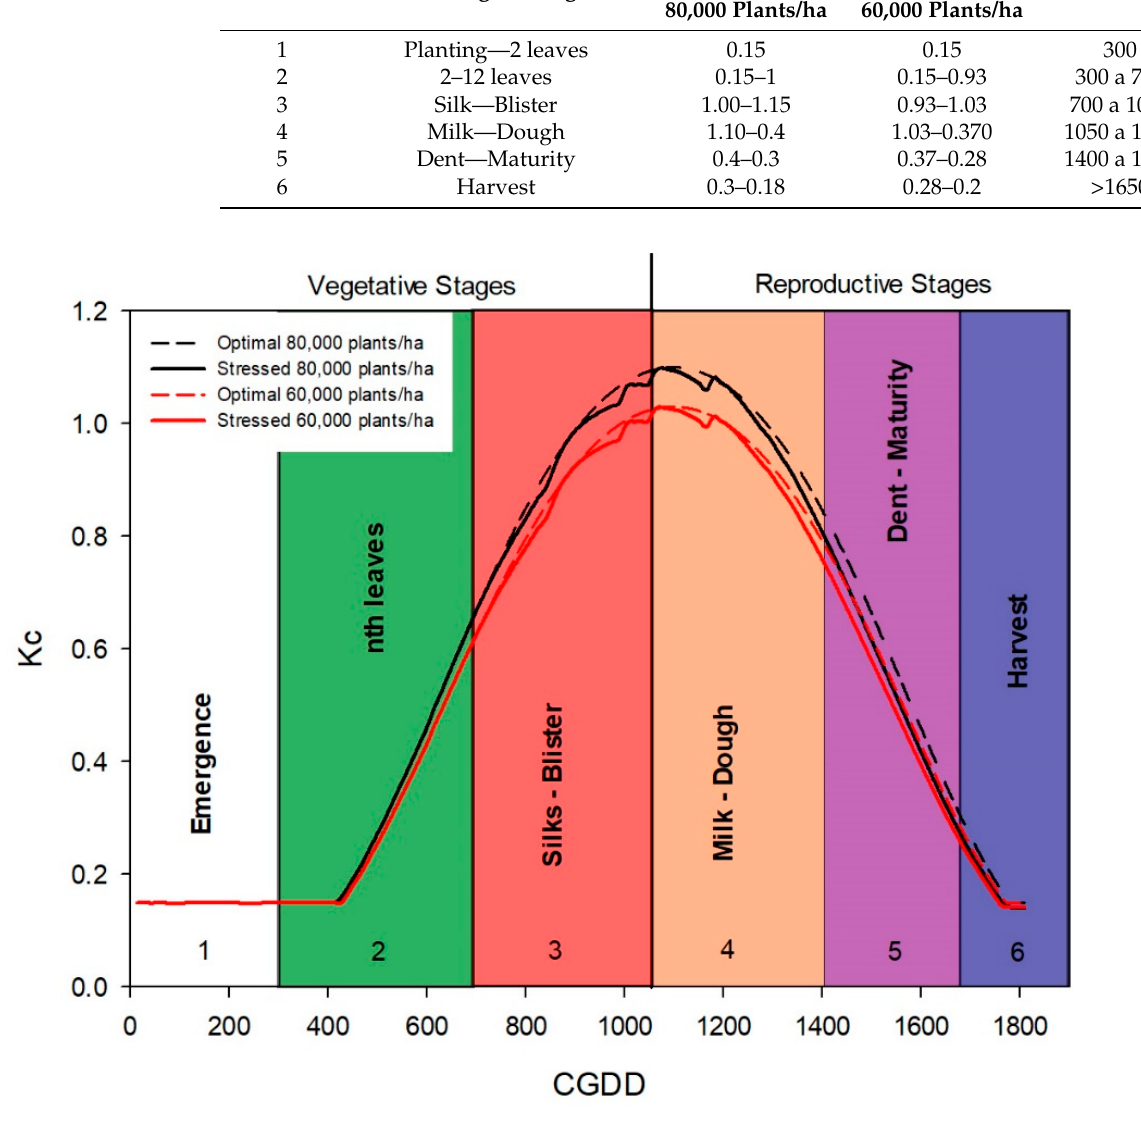
Figure 5. Variation of crop coefficient (Kc)-Cumulative Growing Degree Days (CGDD) values for maize in optimal and stressed conditions.